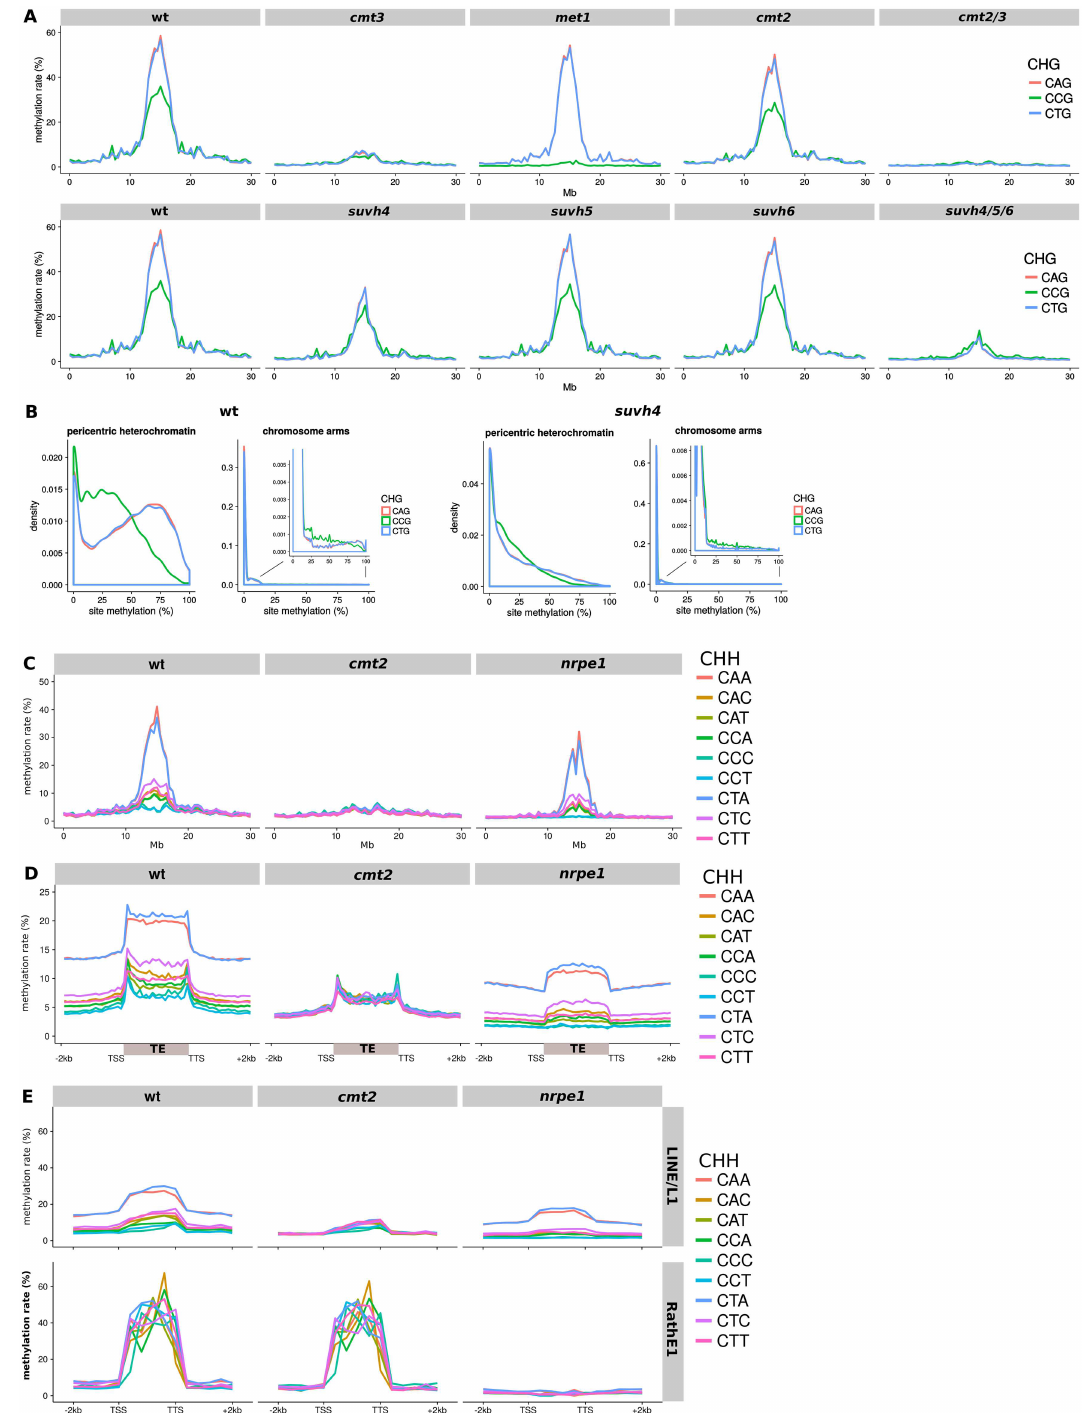
Fig 2. DNA methylation in trinucleotide contexts in A. thaliana mutants. (A) CHG methylationalong chromosome 1. (B) Distributionof per-site methylation levels in CHG subcontexts in the pericentric heterochromatin (13–16Mb) and arms (0–10 and 20–30 Mb) of chromosome 1. (C) CHH methylationalong chromosome 1. (D) Average CHH methylation along transposable elements.(E) Average methylation over two transposonfamilies: LINE/L1 and RathE1. Other transposon families are shown in S12 Fig. TSS, transcriptional start site; TTS, transcription terminationsite.